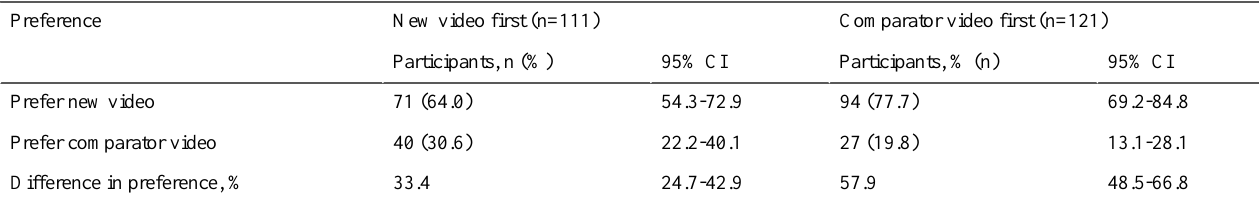
Table 2. Preferred video related to the order of presentation of the videos.